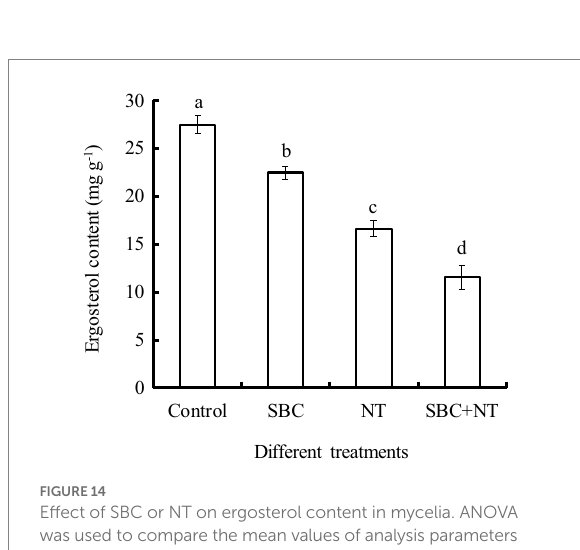
FIGURE 14 Effect of SBC or NT on ergosterol content in mycelia. ANOVA was used to compare the mean values of analysis parameters ( p < 0.05). The results are shown as the mean ± standard deviation ( n = 3). Different superscript letters in the same column indicate significant differences ( p <